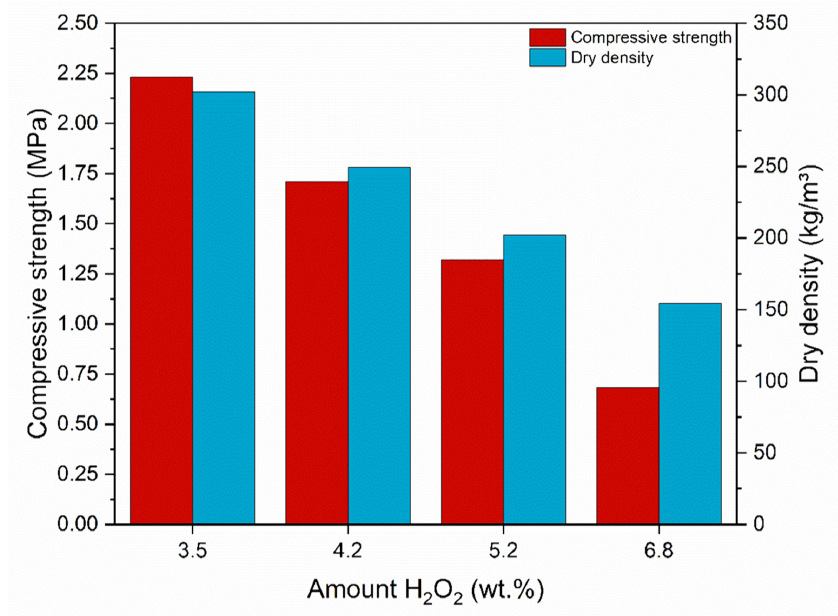
Figure 11. Influence of the amount of H 2 O 2 on dry density and compressive strength according to Reference [73].